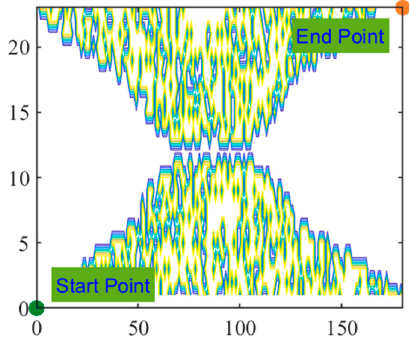
23 of 28 Figure 26. All iterated pre-defined paths and the final pre-defined path in case 2.